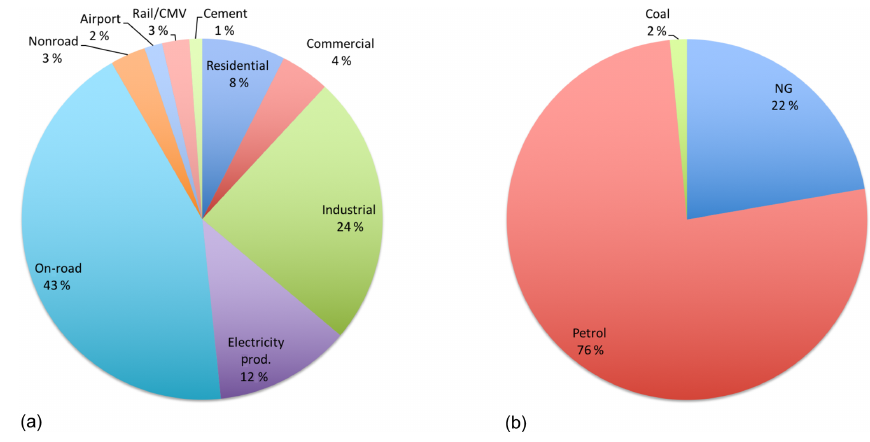
Figure 9. Total FFCO 2 emissions proportions for the Hestia-LA domain: (a) FFCO 2 emission proportions by sector and (b) FFCO 2 emission proportions by fuel category. Table 5. Sectoral FFCO 2 emissions in the five Hestia-LA domain counties for the year 2011. Sector Los Angeles Orange San Bernardino Riverside Ventura Total (MtCyr − 1 ) (MtCyr − 1 ) (MtCyr − 1 ) (MtCyr − 1 ) (MtCyr − 1 ) (MtCyr − 1 ) Residential 2.00 0.64